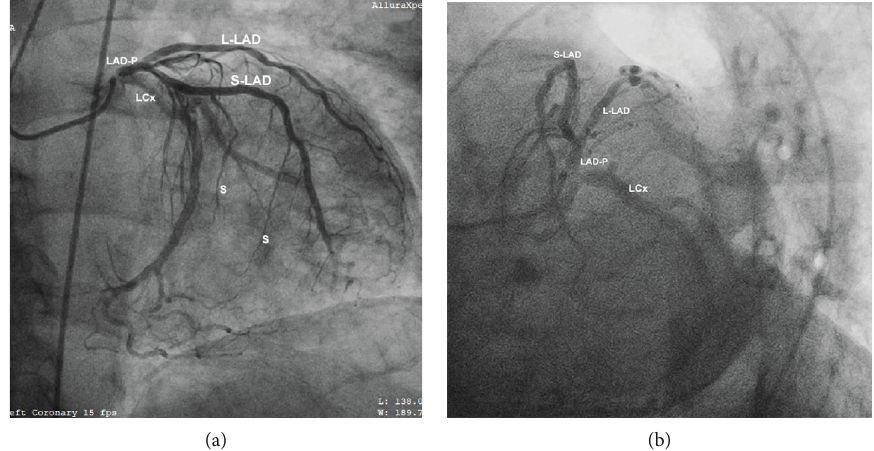
Figure 6: (a, b) Coronary angiogram: right anterior oblique caudal projection (a) and left anterior oblique caudal “ spider ” projection (b). A very short LMCA, best visualized in (b), gives rise to the LCx and a common LAD trunk which we denote as LAD-P. The LAD-P bifurcates into two arteries, S-LAD, giving rise to long septal perforators, and L-LAD reaching the apex, giving rise to shorter perforating arteries and diagonals. LAD-P: left anterior descending proper; L-LAD: long LAD; S-LAD: short LAD; LCx: left circum fl ex artery; S: septal perforating